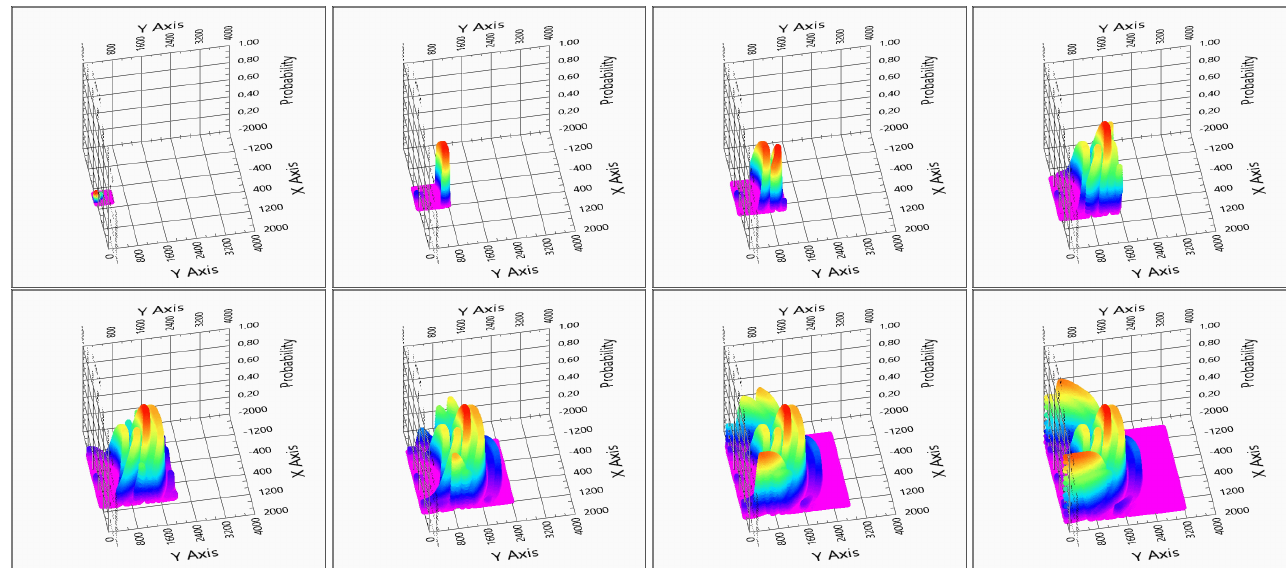
Figure 5. Flowchart of the pre-filtering.